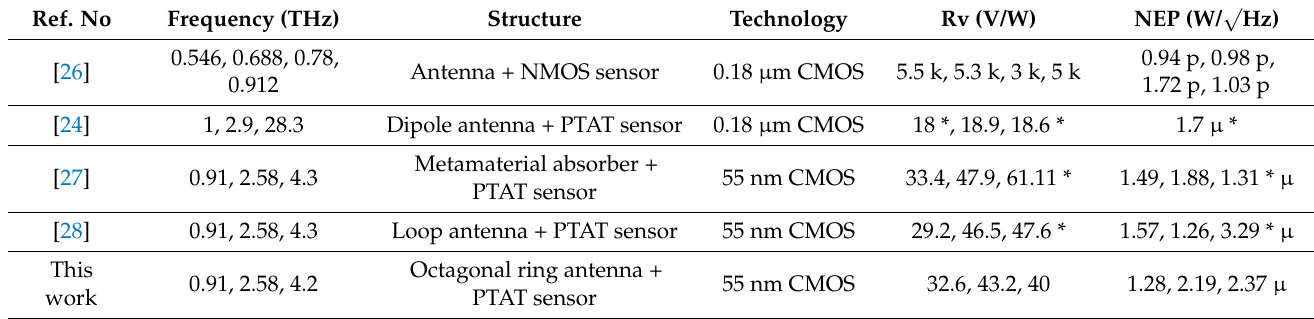
Table 1. Performance summary and